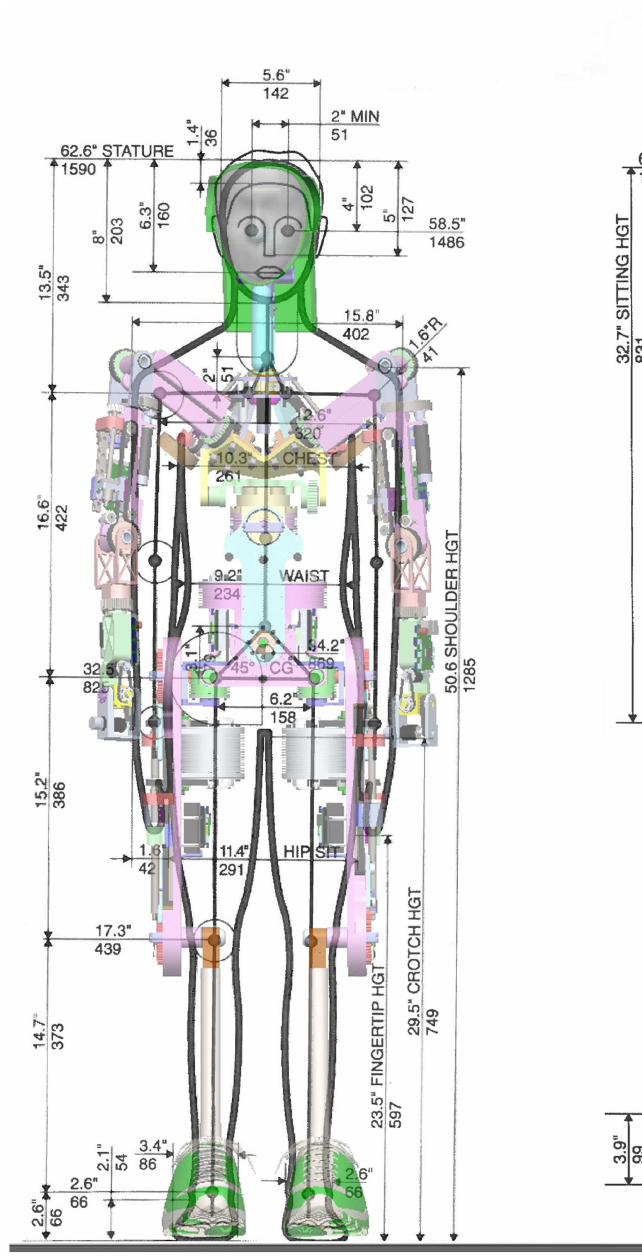
singularities they are angled at 20° forward. Hence, Herbert’s shoulders are not inline on the sagittal